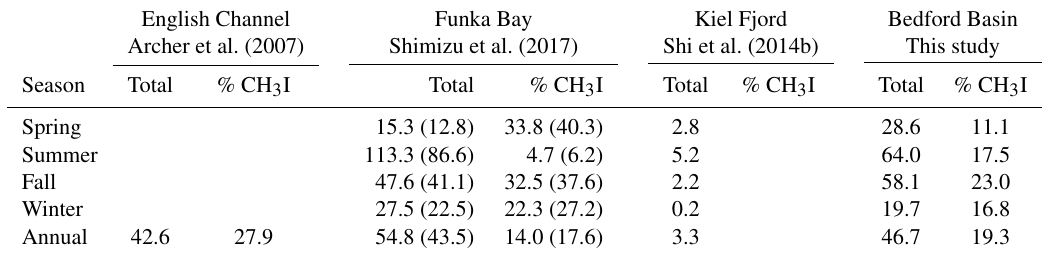
Table 5. Comparison of sea-to-air flux (nmolm − 2 day − 1 ) of total organic iodine from different studies. English Channel is an average for 1 year; Funka Bay value is averaged over 3 years; Kiel Fjord is averaged over 2 years but for CH 3 I only; Bedford Basin (this study) is an average over 3 years. Seasons are as defined in this study (see Sect. 2). For Funka Bay, values in parentheses represent fluxes that have been adjusted from the original reported values to take into account the effect of air-side resistance using correction factors of 12% and 28% for H 2 ClI and CH 2 I 2 , respectively (based on average effects reported in Archer et al. (2007) and this study; see Sect. 4.6). English